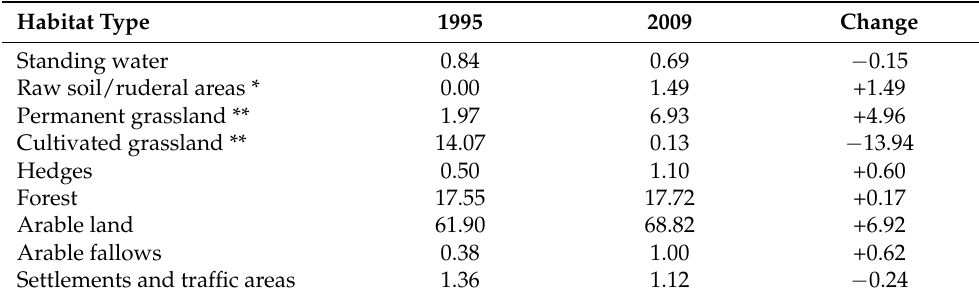
Figure 1. Location of the “Quillow-AgroScapeLab” study area in the northeast German lowlands. Habitat mapping of the area, based on remote sensing, took place in 1995 and 2009 [14], changes over time can be inferred (Table 1). Table 1. Changes in the main habitat types between the two observational campaigns; changes in percentage points (%).